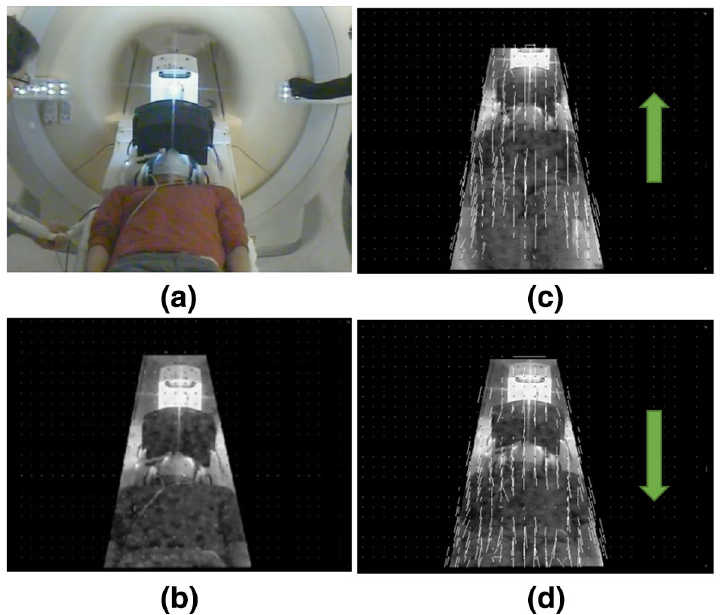
Figure 4. Illustration of patient table tracking: ( a ) the original frame and ( b ) masked grayscale frame. ( c , d ) table motion vectors derived from optical flow at sampled pixels in the masked region when patient table moves.